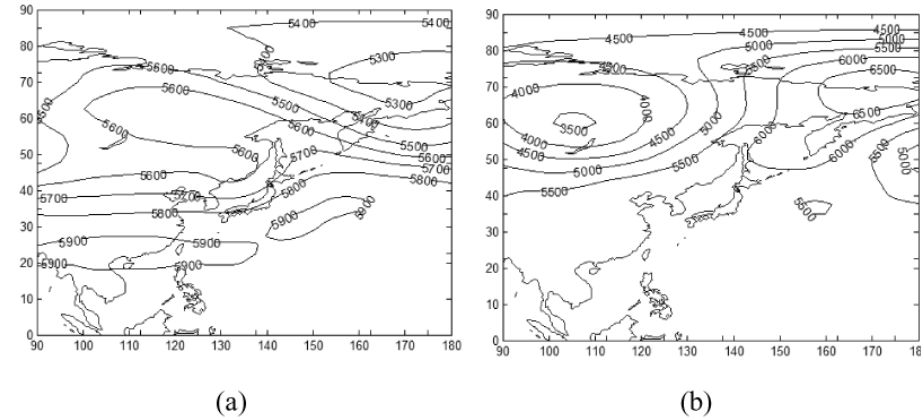
Fig. 2. (a) The potential field of the stable equilibrium and (b) the potential field of the unstable equilibrium of 2003.